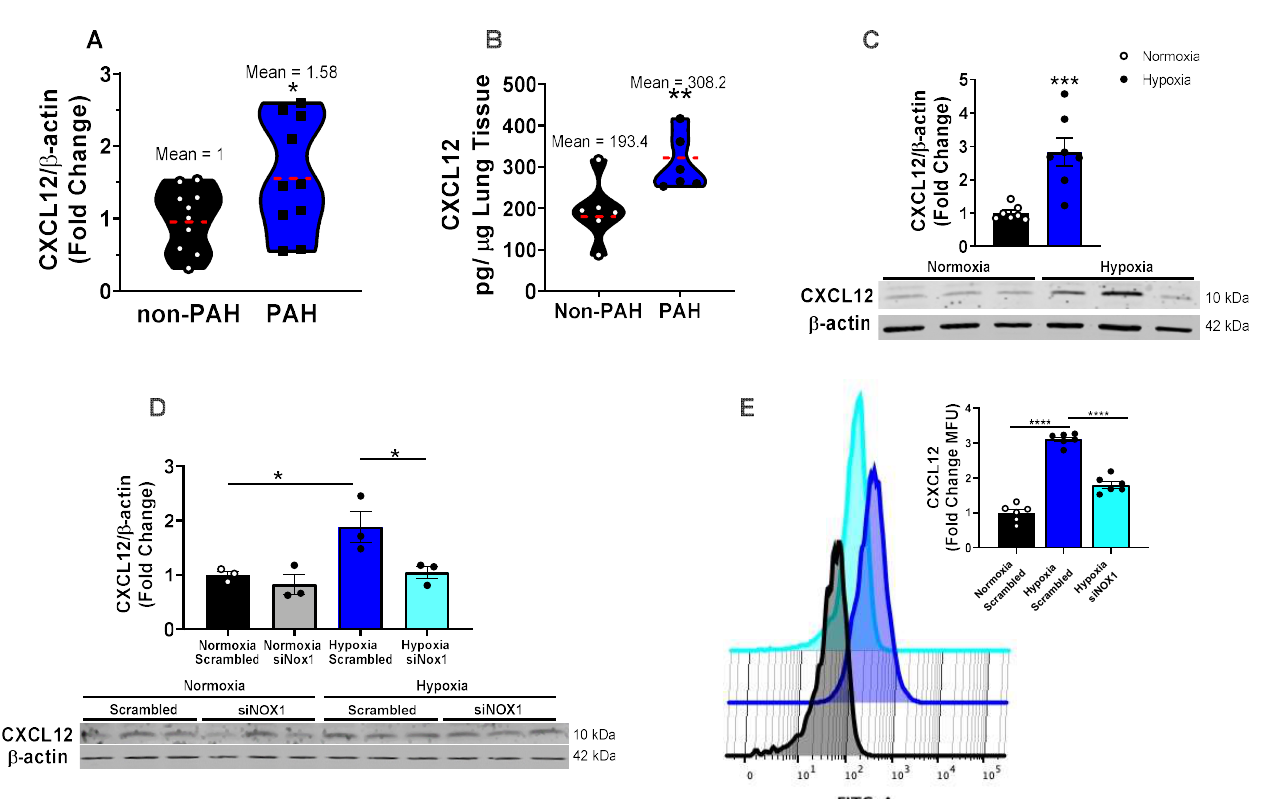
Figure 1. CXCL12 expression is elevated in PAH and is NOX1-dependent in hypoxic pulmonary endothelial cells. ( A ) Western blot analysis of CXCL12 expression in explanted lung tissue samples from PAH or non-PAH patients (n = 6–10). ( B ) ELISA analysis of CXCL12 levels in explanted human lung tissue samples from PAH and non-PAH patients (n = 6–10). Mean values are indicated by a dotted red line. ( C ) Cultured human pulmonary artery endothelial cells (hPAECs) were exposed to 1% O 2 (hypoxia) or normoxia for 48 h and CXCL12 expression was assessed by Western blot (n = 7). D-E. hPAECs were transfected with scrambled or NOX1-targeted siRNAs for 16 h. Cells were exposed to 1% O 2 or normoxia and CXCL12 expression was assessed by ( D ). Western blot or ( E ). flow cytometry (n = 3–6). Representative flow cytometry histograms depict mean fluorescent intensity of FITC along the x axis, with a rightward shift of the peak indicating increased CXCL12 expression. Results analyzed by one-tailed t-test ( A – C ), and one-way ANOVA followed by Holm–Sidak post hoc analysis to determine differences between treatment groups ( D , E ) * p < 0.05, ** p < 0.01, *** p < 0.001, **** p < 0.0001.